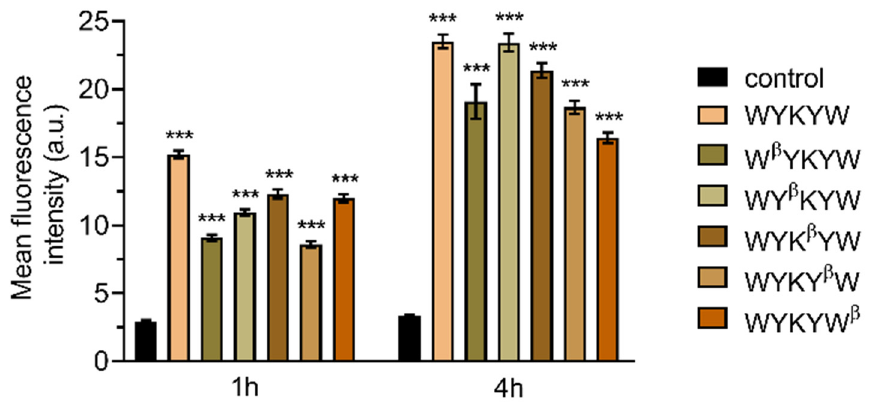
Figure 6. Artificial intelligence-aided quantitative analysis of the live CLSM images. HeLa cells were incubated for 1 or 4 h with the carrier–cargo complexes at 80 nM. At least 150 representative cells were then analyzed at each setup. The graph shows mean fluorescence intensity values ± standard error of the mean (SEM). Statistical analysis was performed using one-way analysis of variance (ANOVA) with Dunnett’s multiple comparison test, where each sample was compared to the control sample of the matching time point. *** p < 0.001.